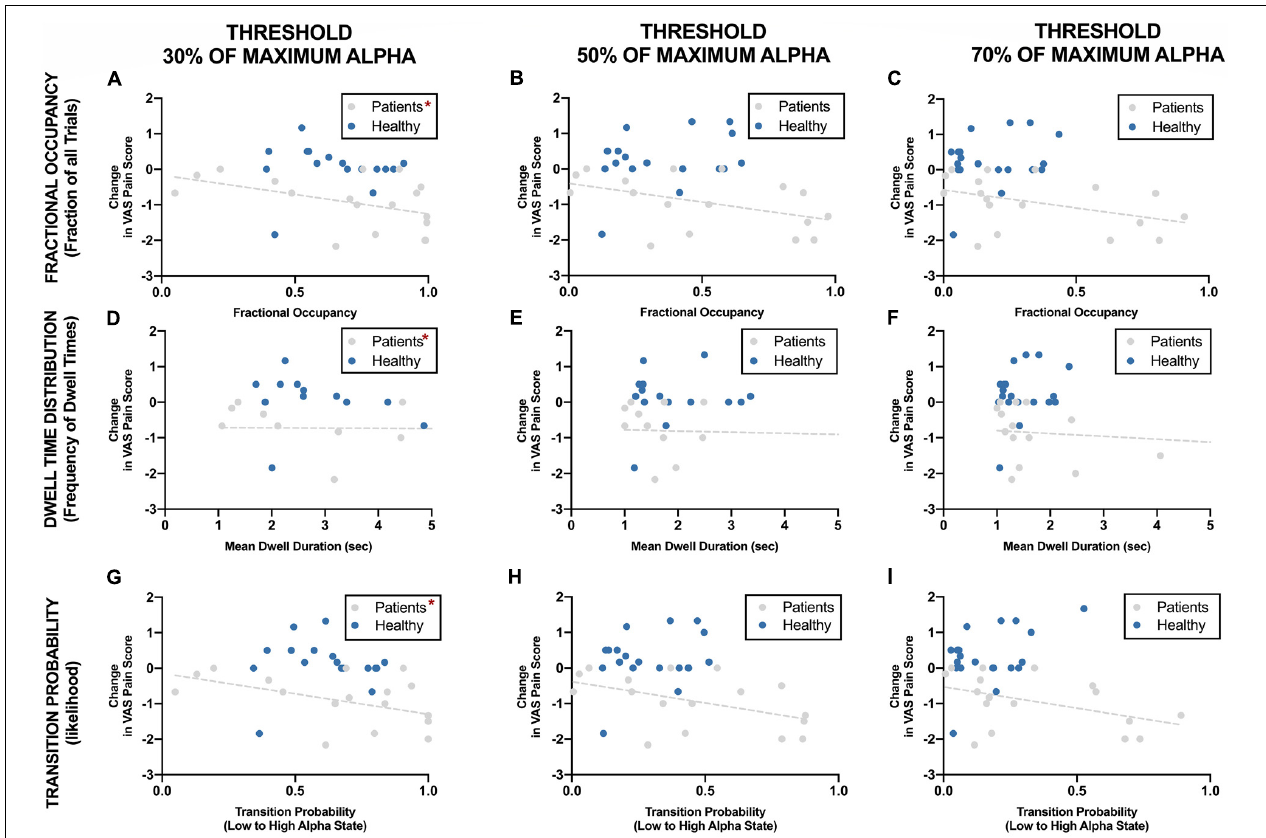
FIGURE 7 | Correlation between EEG alpha state parameters using different thresholds and reduction in VAS pain ratings during neurofeedback sessions. *Statistically significance of p <